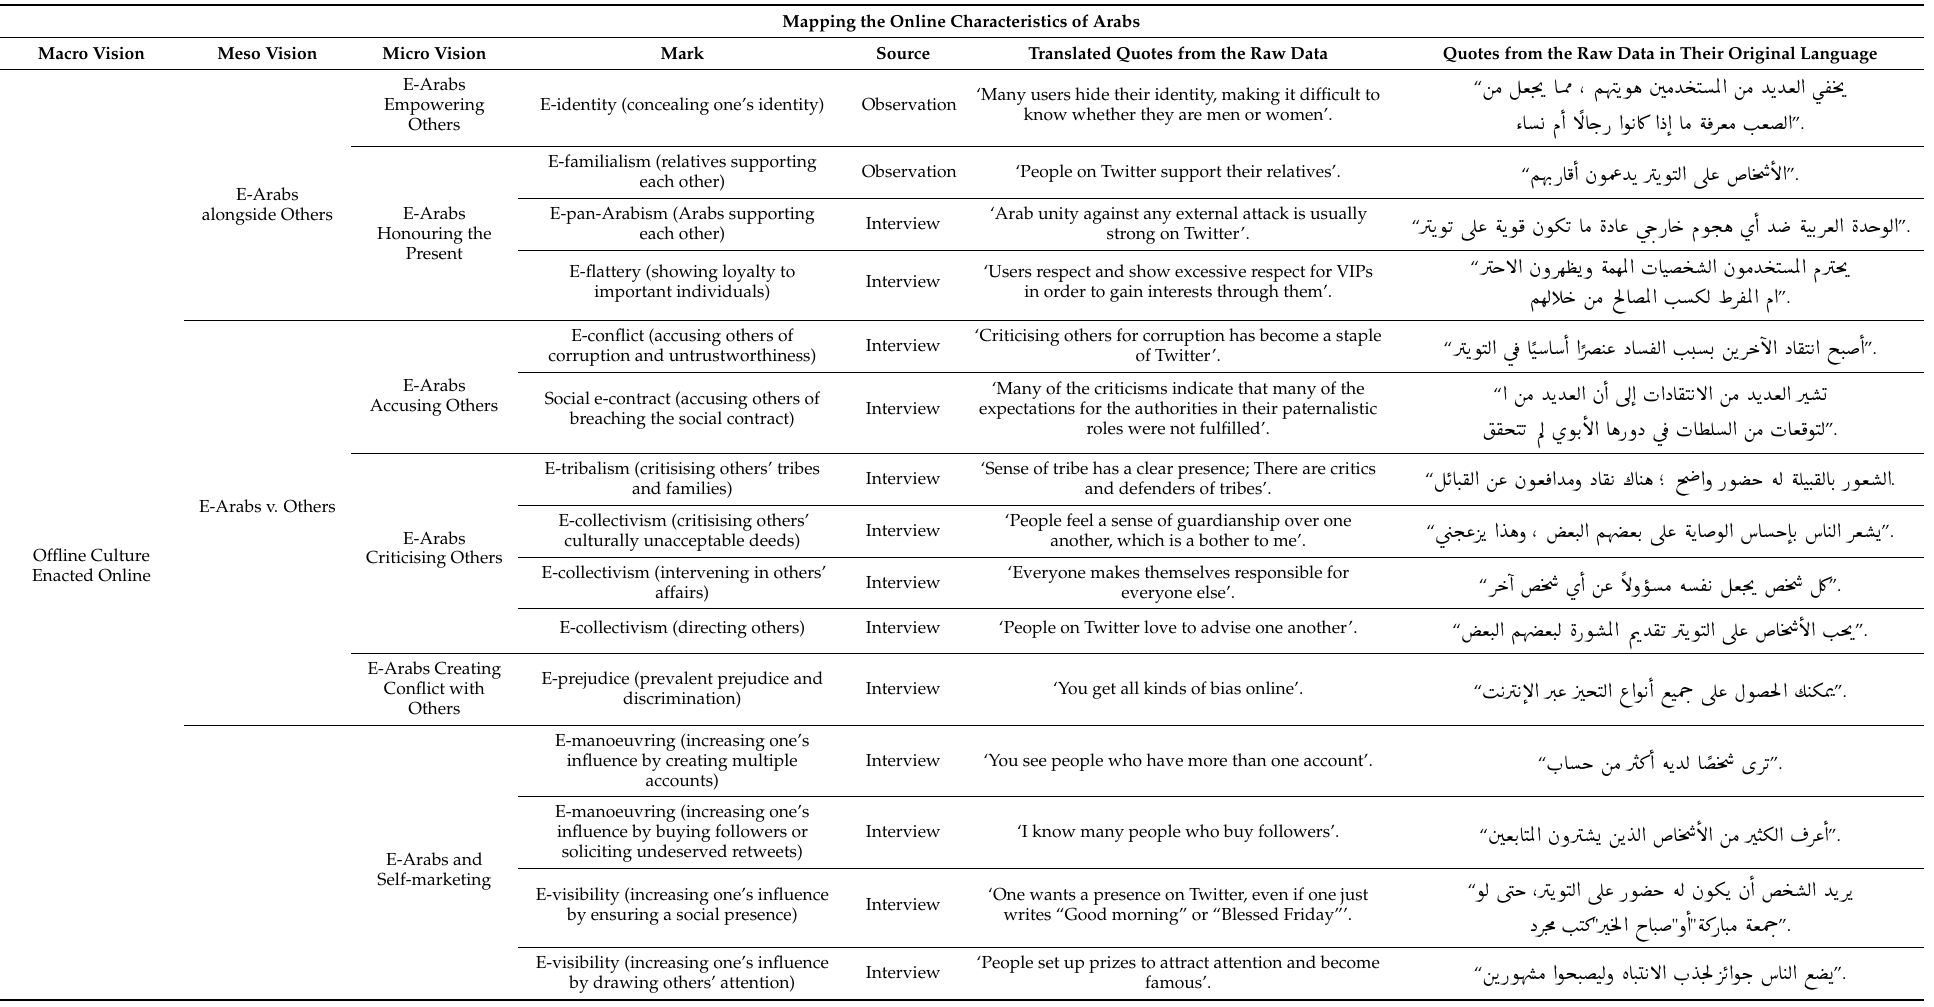
Table 1. Data analysis of interviews and observations to identify whether offline culture is enacted or counteracted online among Arabs. Mapping the Online Characteristics of